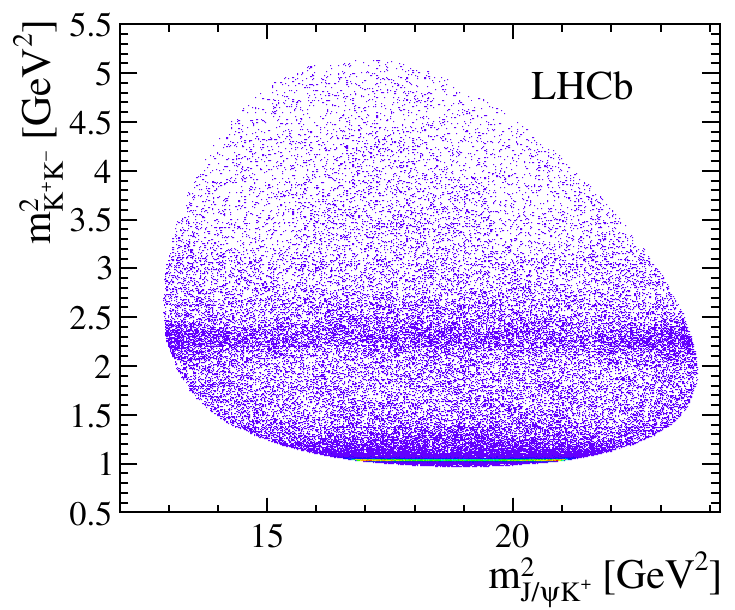
J= K + K (cid:0) candidates within s !